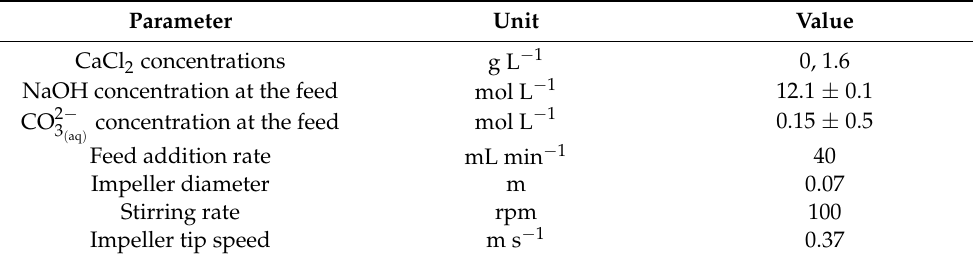
Table 3. Main operating parameters for the CaCO 3 crystallization